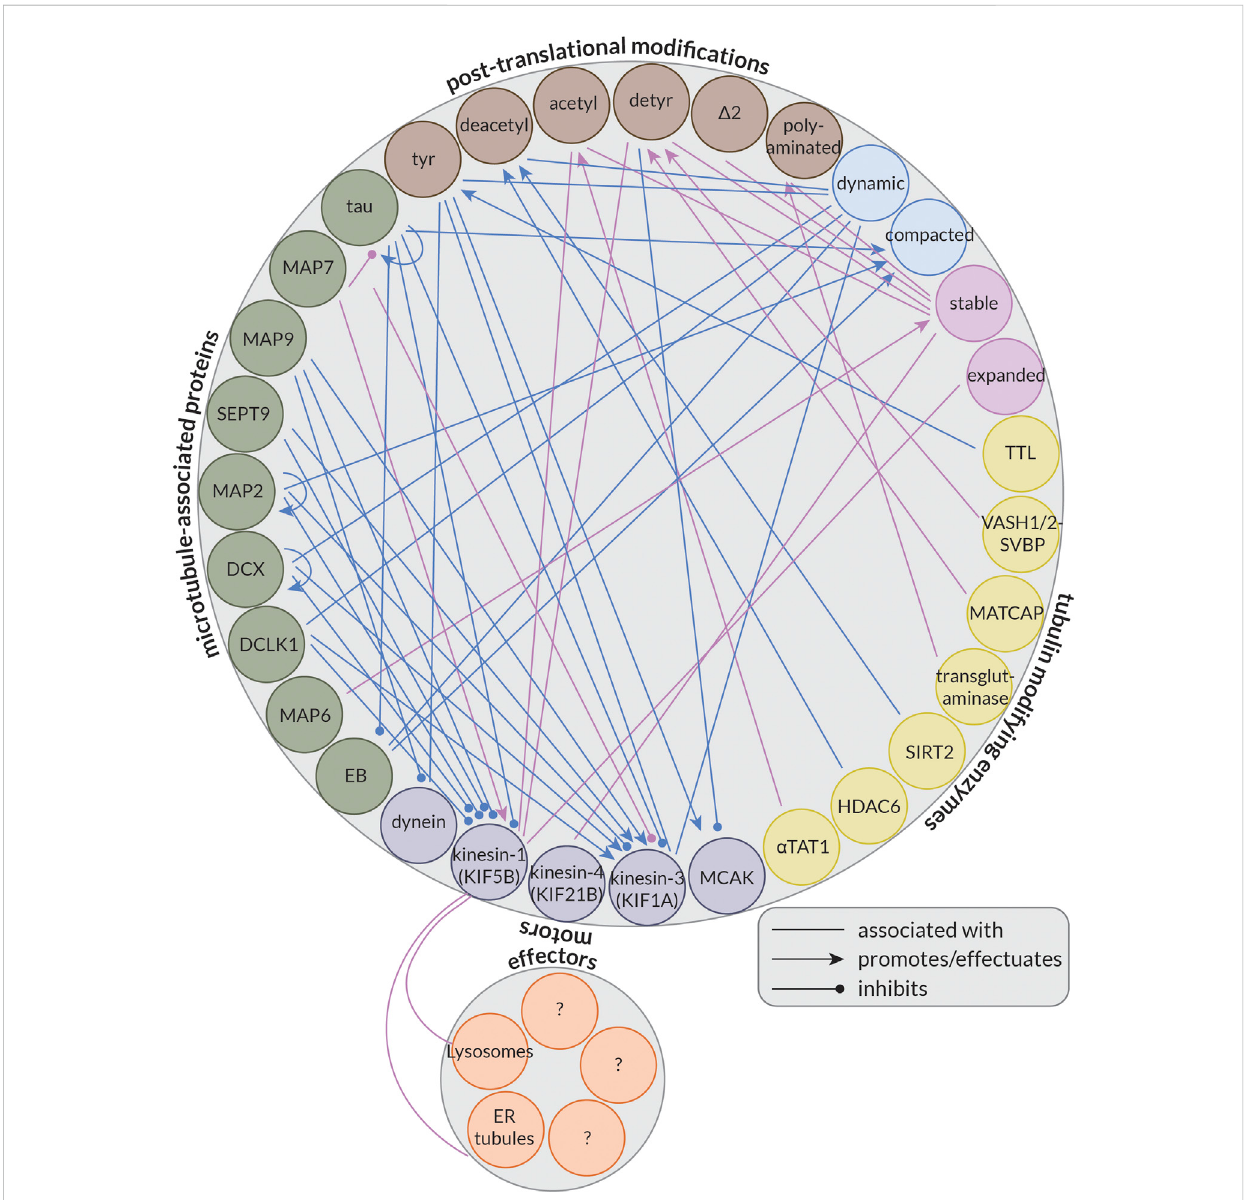
The interplay between different aspects composing microtubule subsets in neurons. A map showing some of the interactions that have been observed for different MAPs, PTMs, tubulin-modifying enzymes, motors, and effectors including which of these factors are associated with, inhibit, or promote others or themselves (cooperativity). Blue lines indicate that the interaction likely takes place on dynamic microtubules. Magenta lines indicate that the interaction likely takes place on stable microtubules. Note that for kinesin-1 there are many inhibitory MAPs that are (likely) associated with dynamic microtubules, preventing it from using these as tracks, whereas for kinesin-3, some of these MAPs are not or less inhibitory, permitting it to use these as tracks. This in turn impacts whether the respective cargoes are associated with stable or dynamic microtubules. See text and Table